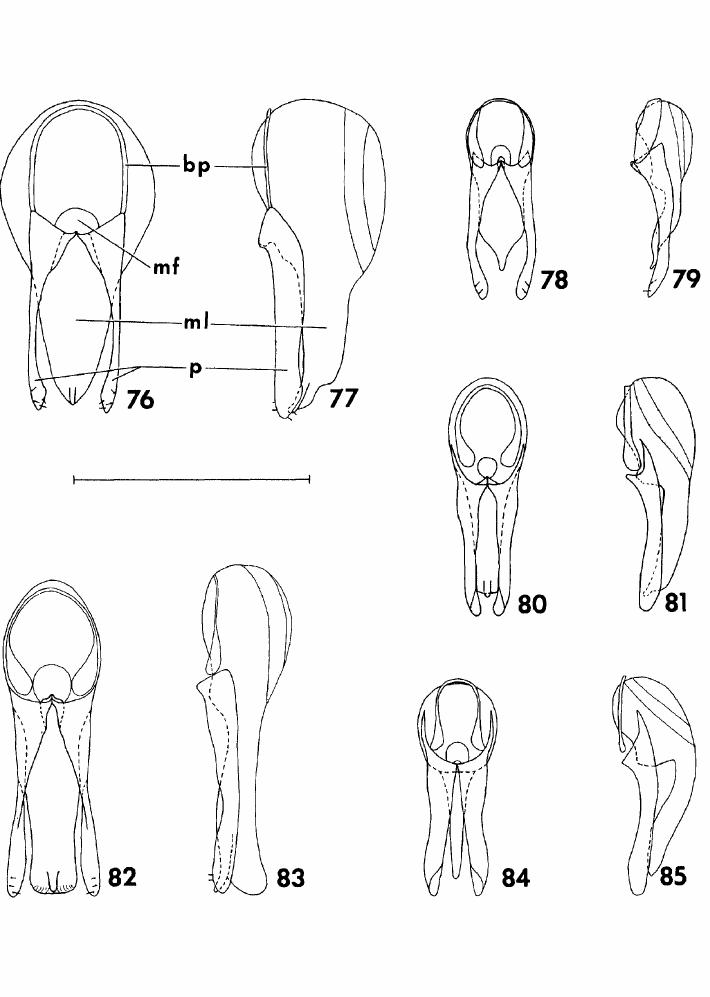
Figs. 76-85. Glypholoma spp., aedeagus (in situ), dorsal and right lateral views, respectively. 76-77, G. tenuicorne; 78-79, G. rotundulum; 80-81, G. pecki; 82-83, G. temporale; 84-85, G. pustuliferum, bp basal piece; mf median foramen; ml median lobe; p paramere. Scale line 0.5